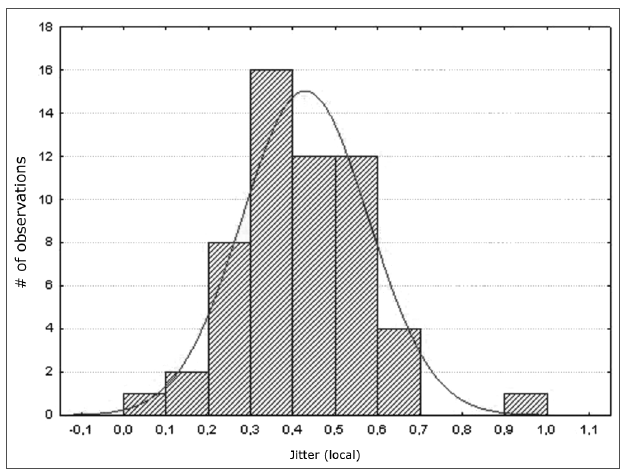
Figure 2. Normal distribution of jitter (local) - Histogram